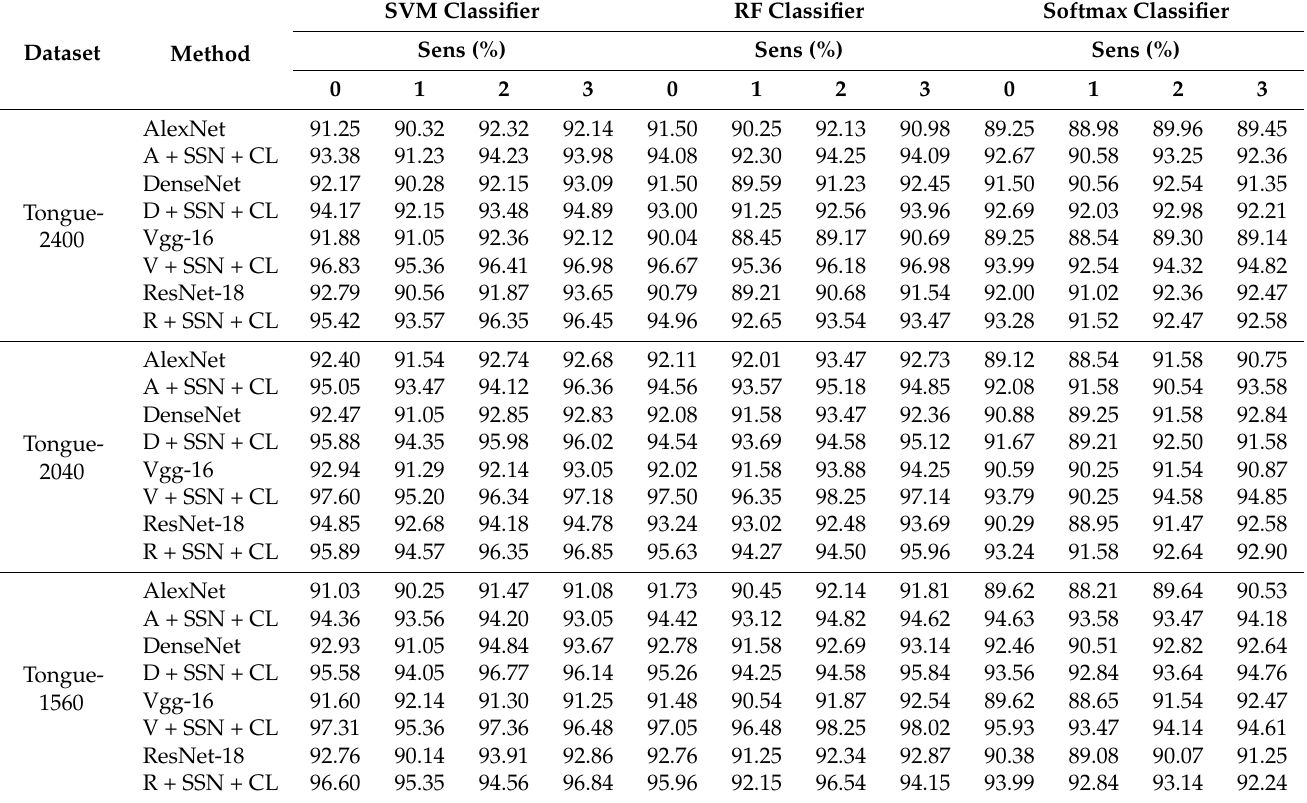
Table 3. Sensitivity comparison of different methods under best mean overall